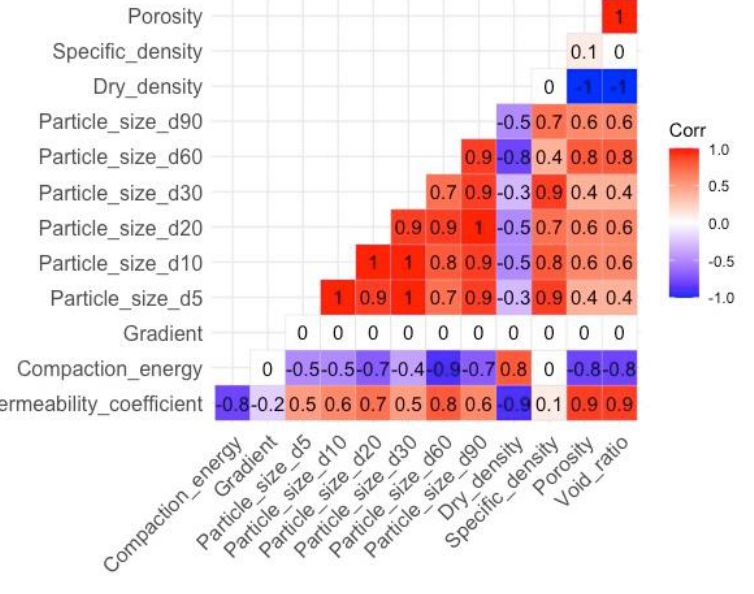
Figure 5. Correlation analyzed.